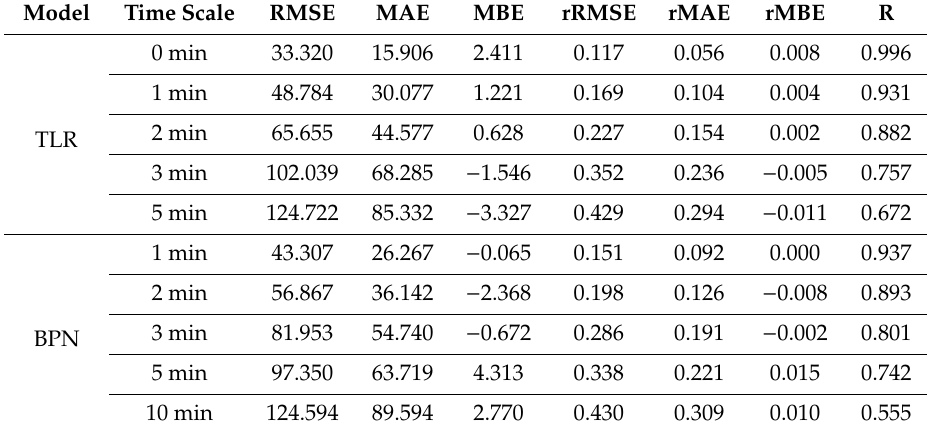
Table 2. Forecasting error comparison between the linear regression model and the neural network model on 7 November 2017.